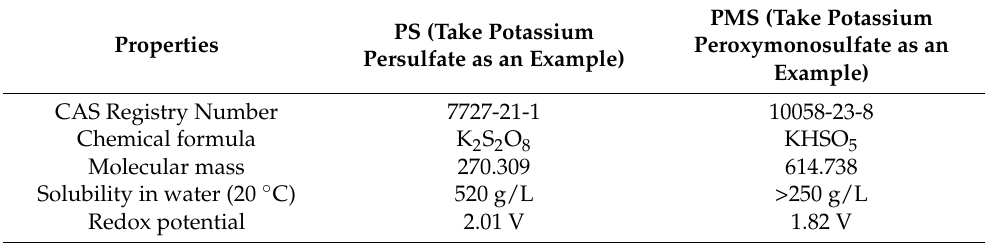
Table 1. Properties of PMS and